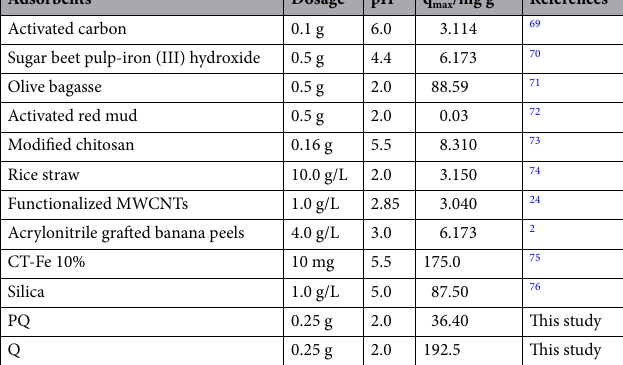
Adsorbents Dosage